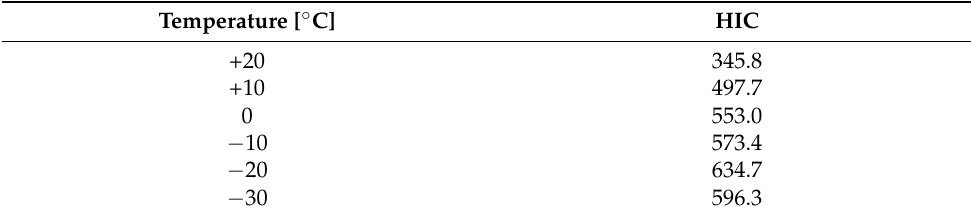
Table 1. Maximum HIC value depending on